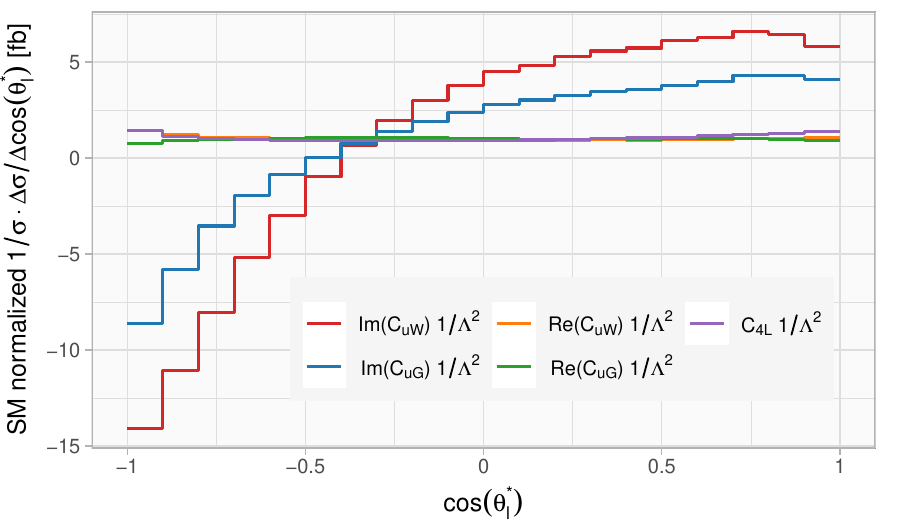
Figure 22. To itself and to the SM normalized SMEFT contributions to the cos (cid:18) (cid:3) at NLO in QCD . Results are presented for the real and imaginary parts of C 33 as for the four quark operator C 4 L .